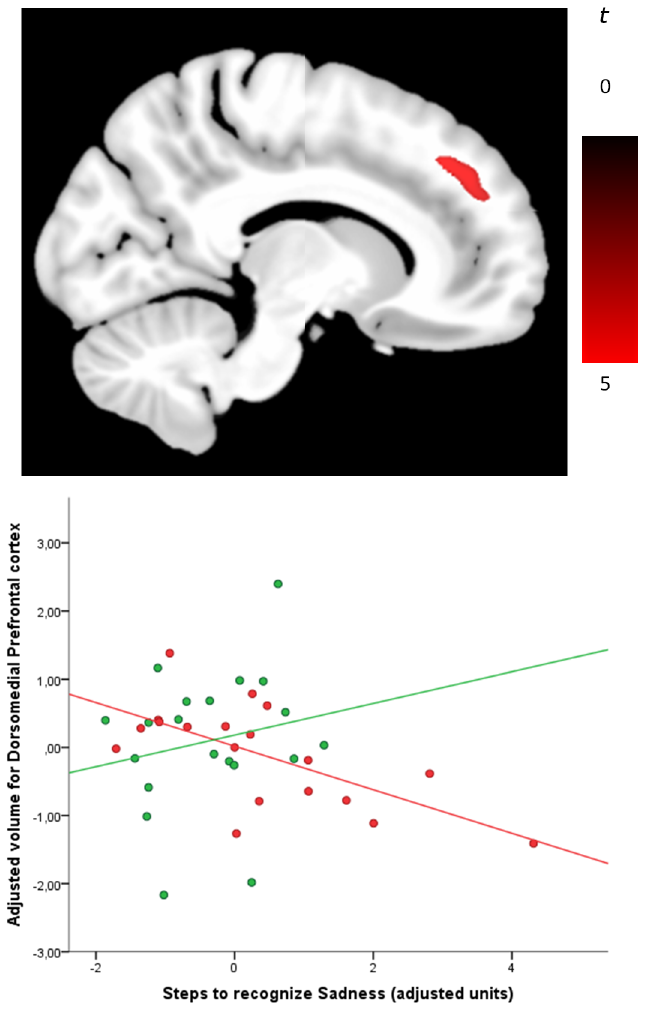
Fig 1. The specific contribution of regional GM volumes in the dorsomedial prefrontal cortex (MNI coordinates, x = 17, y = 43, z = 33) to improved sadness recognition in psychopaths was explained by a negative association in this group (red) but a positive association in controls subjects (green). The plot displays residual values once covariates were controlled for. The sagittal display corresponds to the right